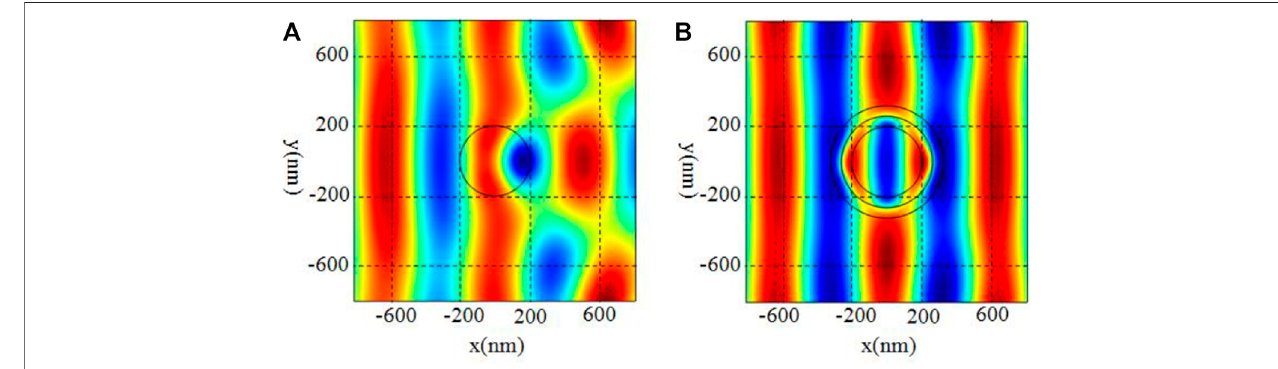
FIGURE 2 | (Color online) The electric fi eld excited by the 632.8 nm plane optical wave (A) without and (B) with the